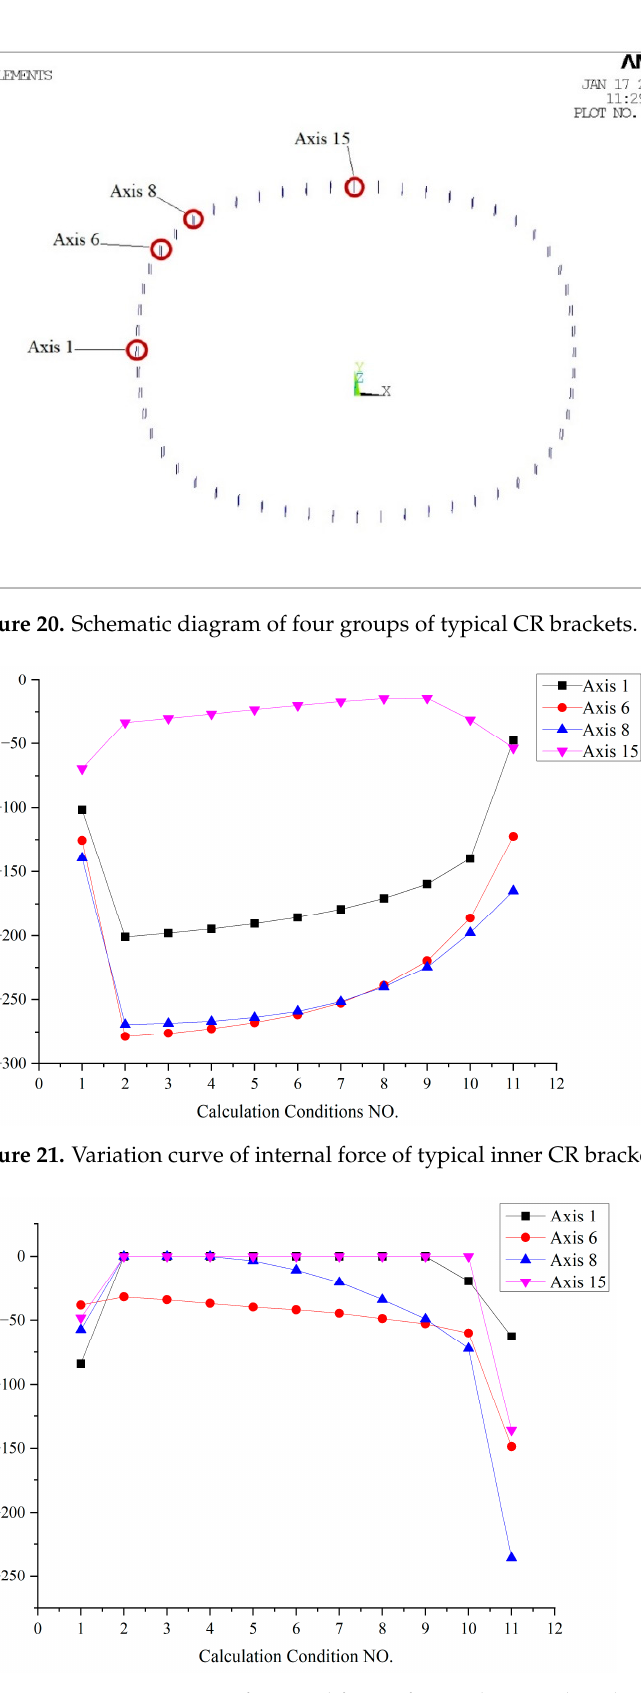
Figure 22. Variation curve of internal force of typical external CR